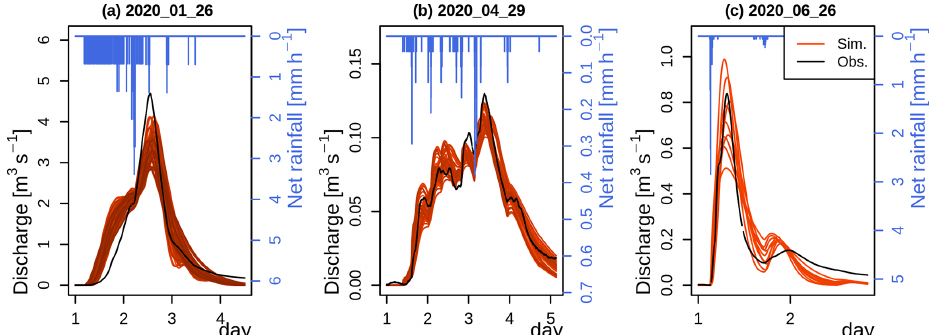
Figure 7. Examples of simulated events for the Koedange subcatchment. Event (a) is representative of the winter event simulations. The displayed event on panel (b) is representative of the well-simulated events. On panel (c) is displayed the summer event on 26 June 2020, where the peak discharge tends to be underestimated while the second moderate event is overestimated.